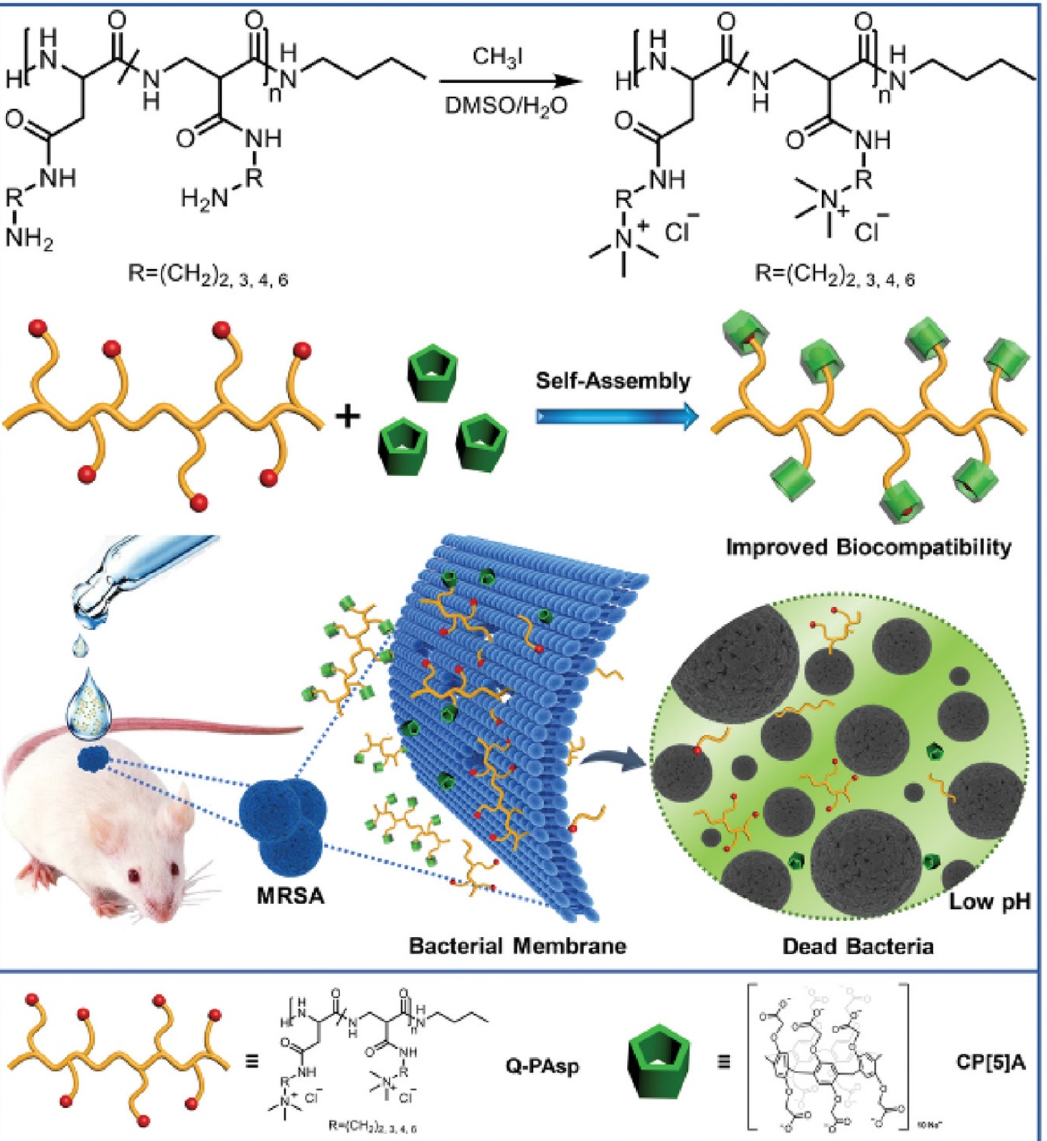
Figure 6. Schematic illustration for construction of supramolecular antimicrobial system and its antibacterial property for healing MRSA-infected wound. Reprinted with permission from Ref. [78]. Copyright 2019 Wiley-VCH.